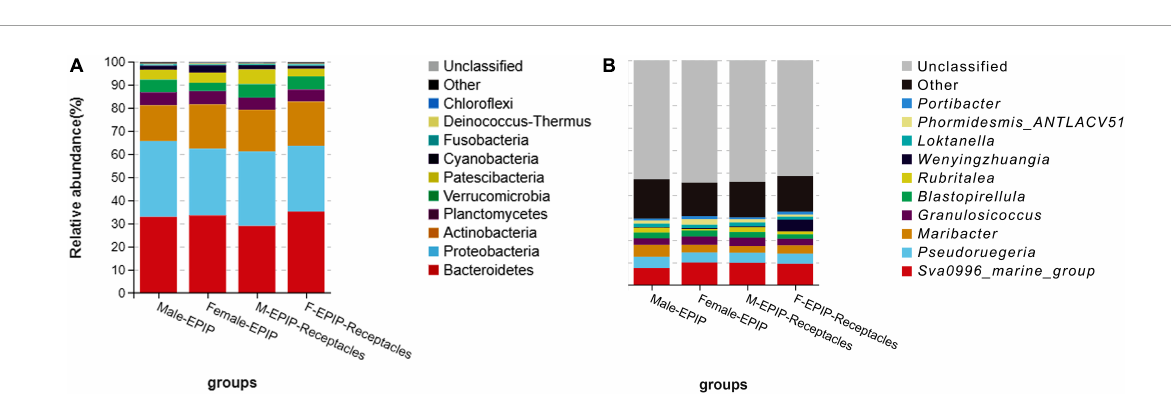
FIGURE4 Relative abundance of epiphytic bacteria on algal bodies and receptacles of male and female S. thunbergii. (A) Phylum level. (B) Genus